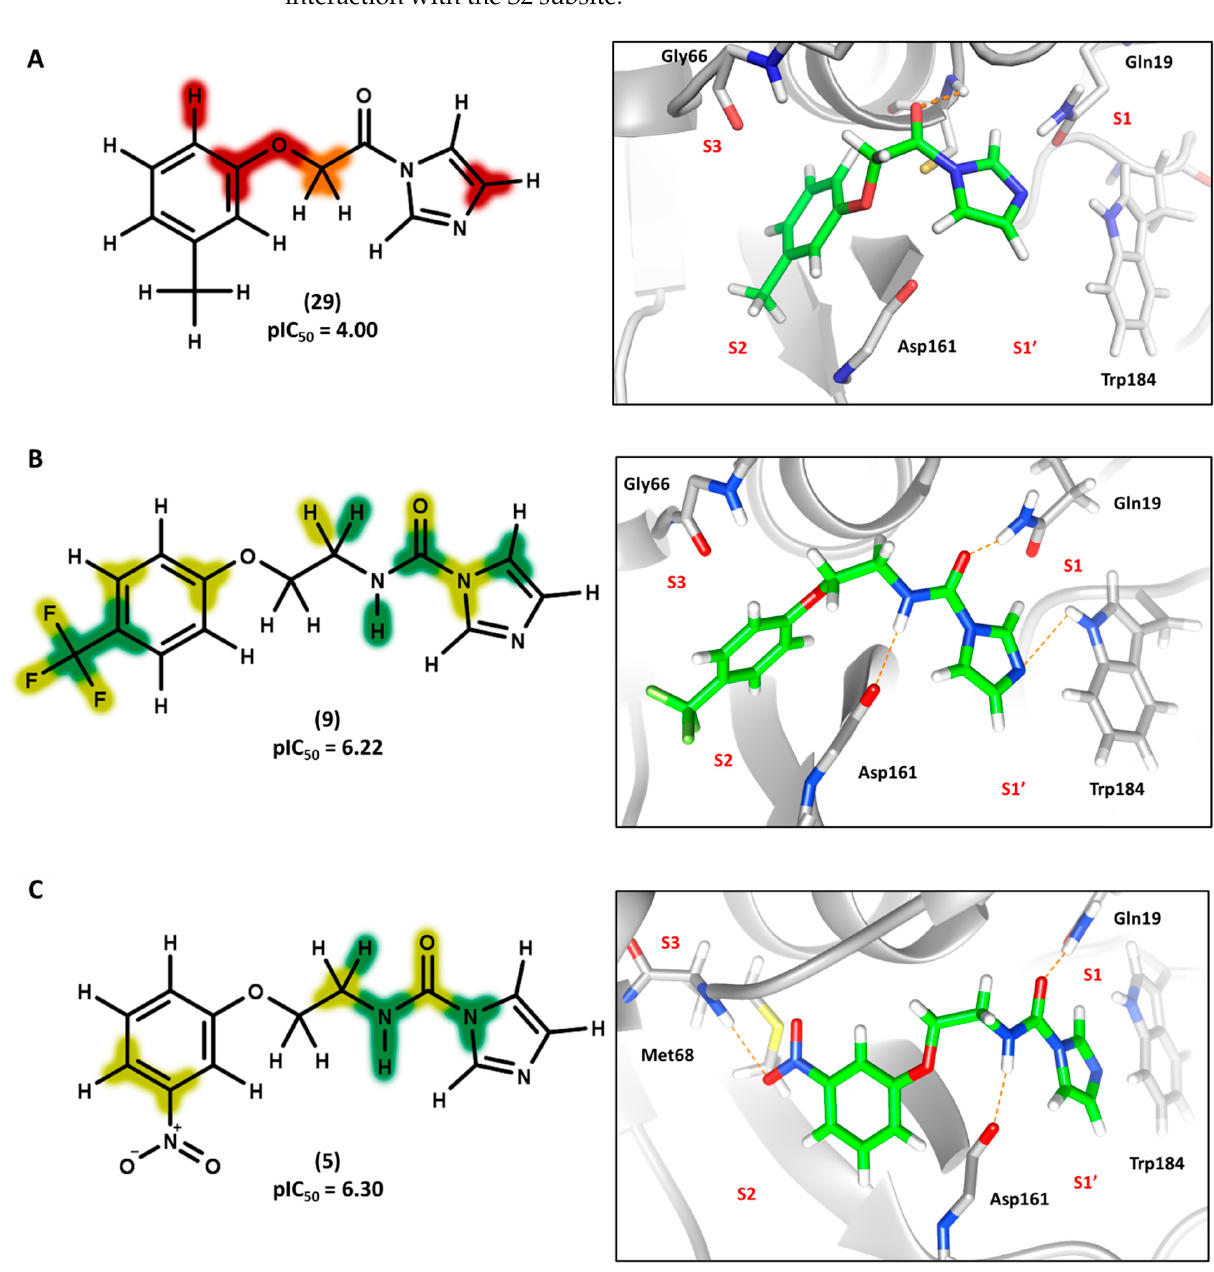
Figure 5. Contribution maps showing the key role played by the imidazole, linker, and aryl halide fragments in activity and binding conformations predicted by molecular docking. ( A ) Compound 2; ( B ) compound 3; ( C ) compound 6. Inhibitors and active site residues are depicted as sticks, and hydrogen bonds are shown as dashed lines. Contribution maps: Yellow and green represent positive contributions, while red, orange, and red-orange indicate negative contributions to activity. White represents intermediate contributions.